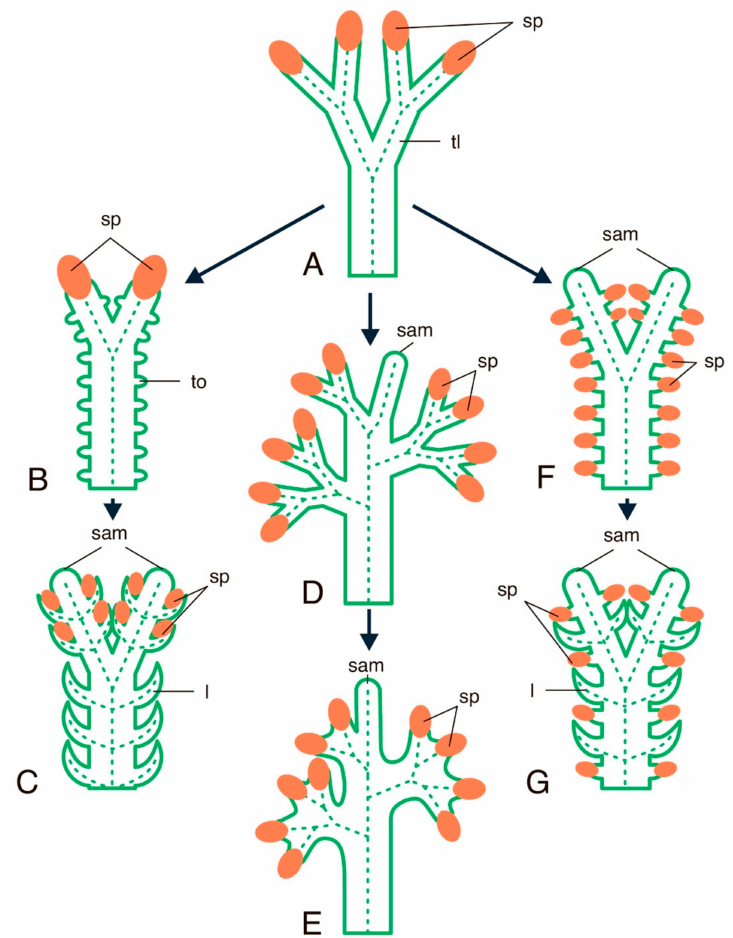
Figure 1. Summary of hypotheses on the origin of leaves in sporophytes of land plants. ( A ) Leaflesss rhiniophyte ancestor. ( B , C ) Successive stages of leaf origin as outgrowths of the cortex and epidermis of leafless telomes combined with the displacement of sporangia from terminal to lateral position. ( D , E ) Successive stages of leaf origin as a result of modification of the system of the leafless axes, or telomes (overtopping, planation and webbing). ( F , G ) Successive stages of leaf origin as a result of displacement of sporangia from a terminal to a lateral position combined with consequent sterilization of some sporangia. Schemes are based on descriptions and/or drawings of [1–5,8]. l—leaf, sam— shoot apical meristem, tl—telome, to—telome outgrowth, sp—sporangium. Dashed lines stand for the provascular and vascular tissues of stems and leaf